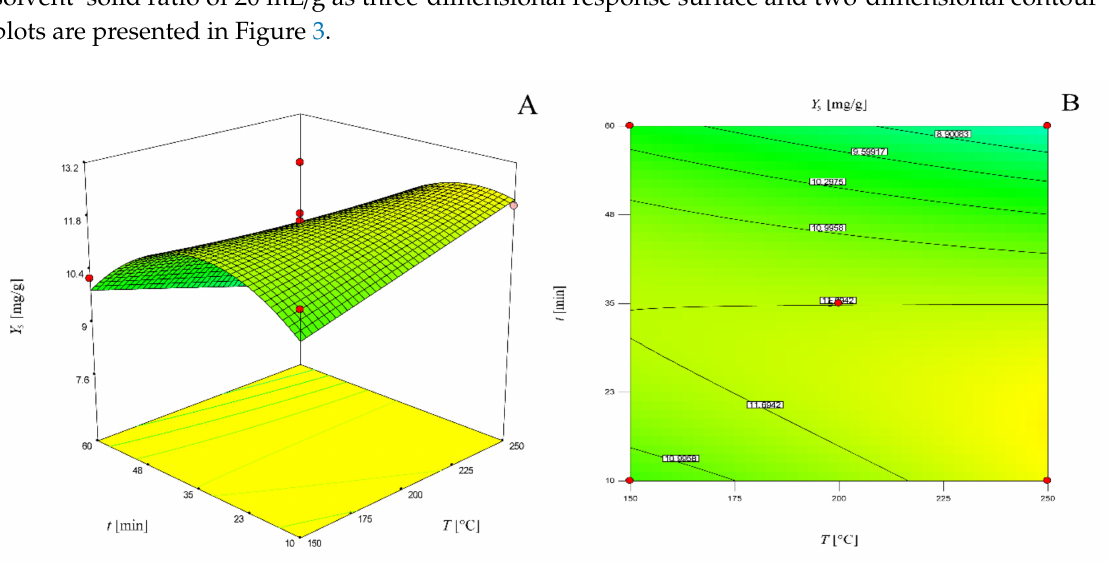
Figure 3. Three-dimensional response surface ( a ) and two-dimensional contour plot ( b ) of the model for determination of ellagic acid yield for solvent-solid ratio of 20 mL /